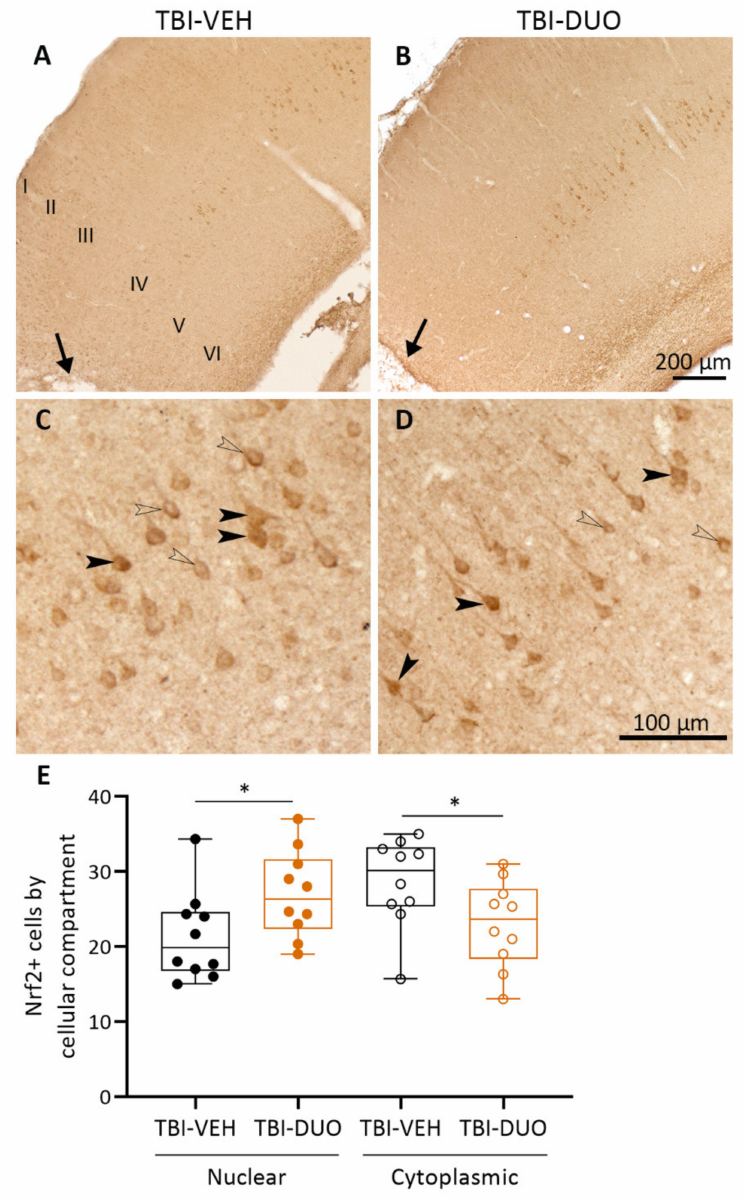
Figure 8. Nrf2+ immunostaining in the ipsilateral cortex. Low magnification photomicrographs showing Nrf2+ immunostaining mainly in cortical layer IV in ( A ) TBI-VEH and ( B ) TBI-DUO animals on day (D) 14 post-TBI. Note the lack of immunopositive neurons in a ~1-mm wide sector from the lesion core (lesion core is indicated with an arrow in panels A and B). Cortical layers are labeled with Roman numerals. High magnification photomicrographs showing nuclear (closed arrowhead) and cytoplasmic (open arrowhead) staining of Nrf2 in ( C ) TBI-VEH and ( D ) TBI-DUO animals. ( E ) Quantitative analysis indicated that the duotherapy increased nuclear localization and decreased cytoplasmic localization of Nrf2. Abbreviations: D, day; DUO, duotherapy treated with N-acetylcysteine and sulforaphane; Nrf2, nuclear factor erythroid 2-related factor-2; TBI, traumatic brain injury; VEH, vehicle. Statistical significances: * p < 0.05 Student’s t -test. Data are presented as whisker-plots with mean and minimum/maximum. Scale bar equals 200 µ m in panels A–B and 100 µ m in panels